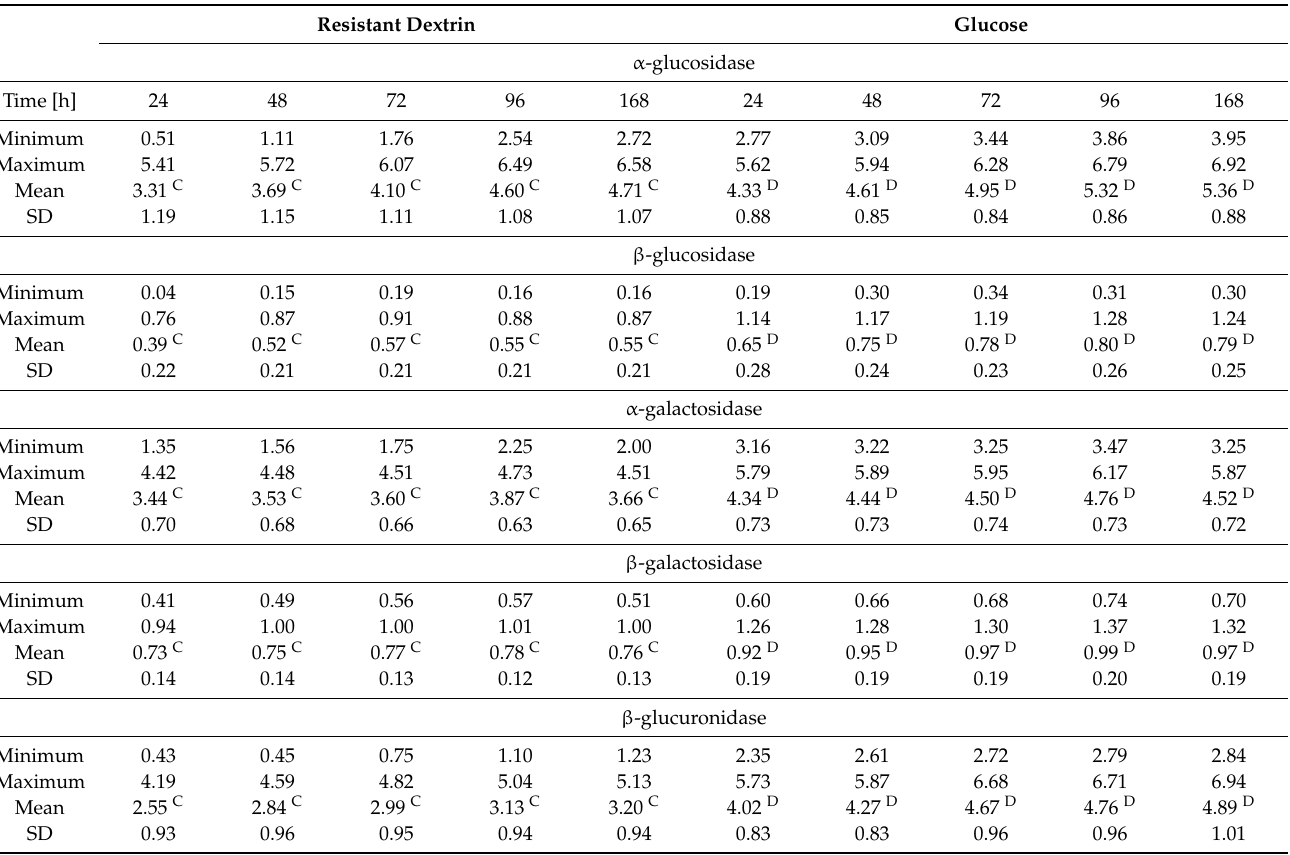
Table 3. Comparison of activities of the fecal enzymes in the samples cultivated on medium with the resistant dextrin or glucose (control) as a source of carbon. Resistant Dextrin Glucose α